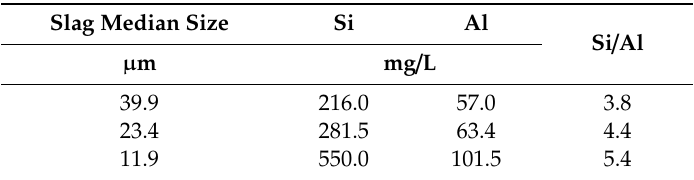
Table 8. Concentration of Si and Al as well as Si / Al ratio in solution after leaching of slag with di ff erent particle size with